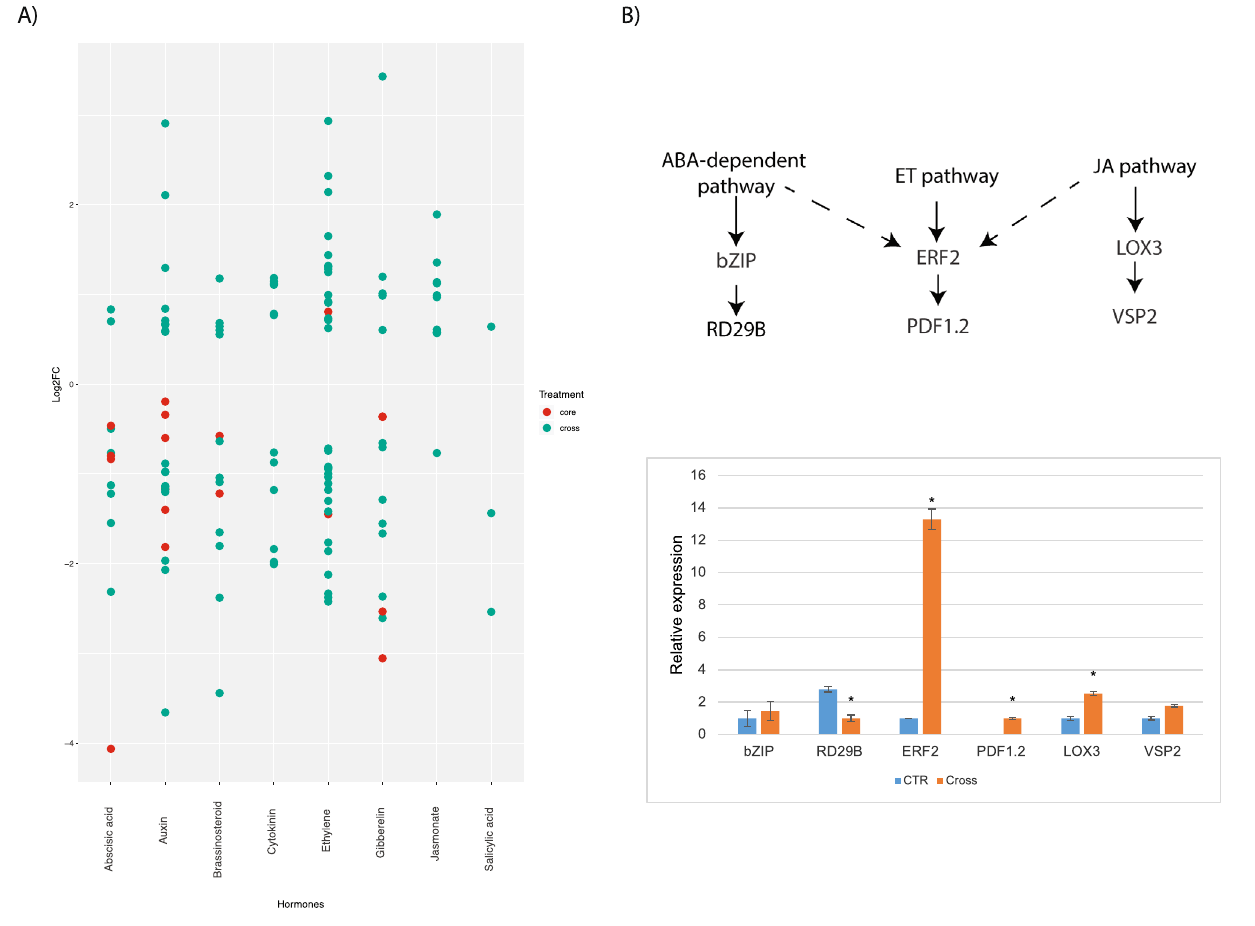
Figure 4. (A) Dot-plot of the expression patterns of Arachis DEGs involved in hormone pathways: red-core- metaDEGs; green-crossDEGs. Each dot represents the relative expression value (log2FC) of a DEG in the y-axis; (B) qRT-PCR: relative quantification of mRNA levels of marker genes in the ABA, JA and ET pathways in A. stenosperma roots submitted to cross-stress treatment relative to non-treated control samples. Values are the mean standard deviation of three biological replicates and * means significant differences (p < 0.05). NAS not amplified